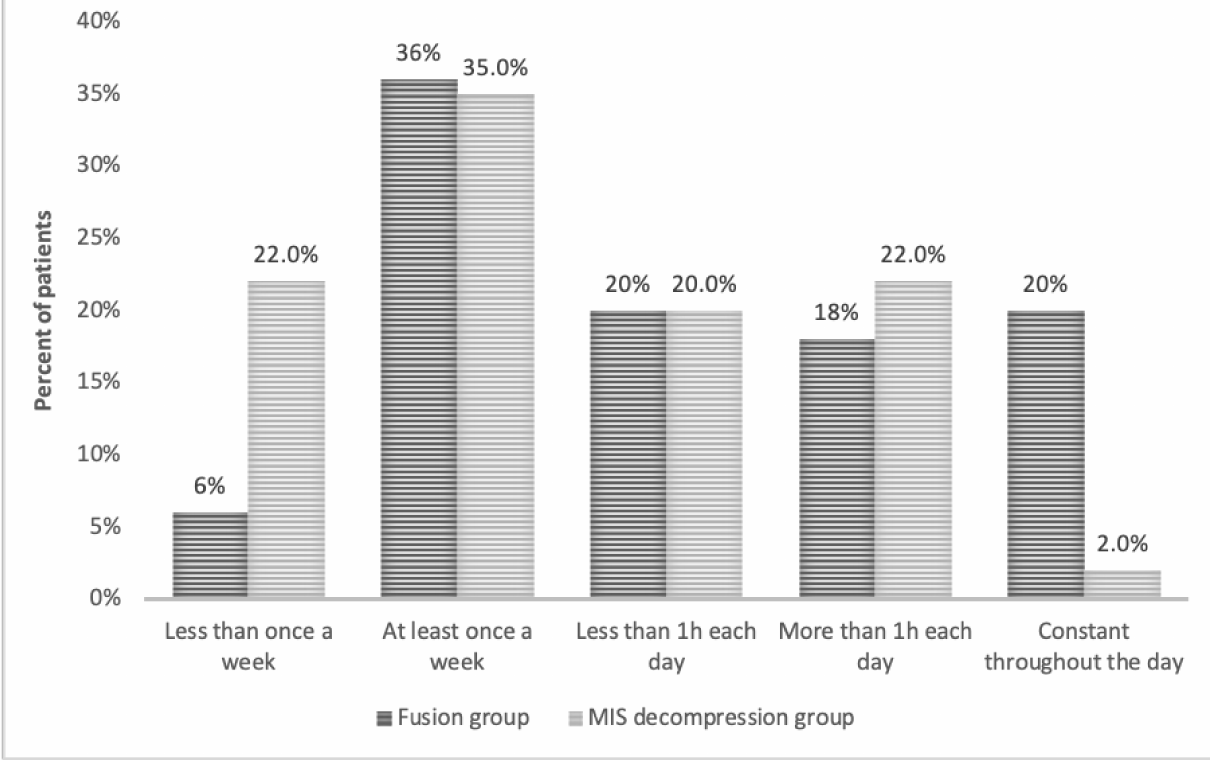
Figure 4. Pain frequency among the MIS and fusion